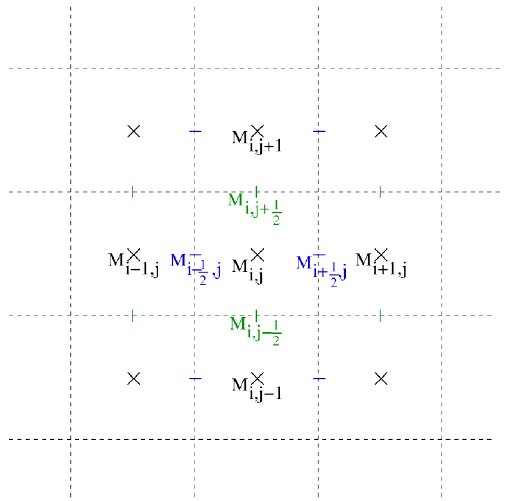
Figure 1. Centered (black) and staggered (blue and green) grid points in the Arakawa